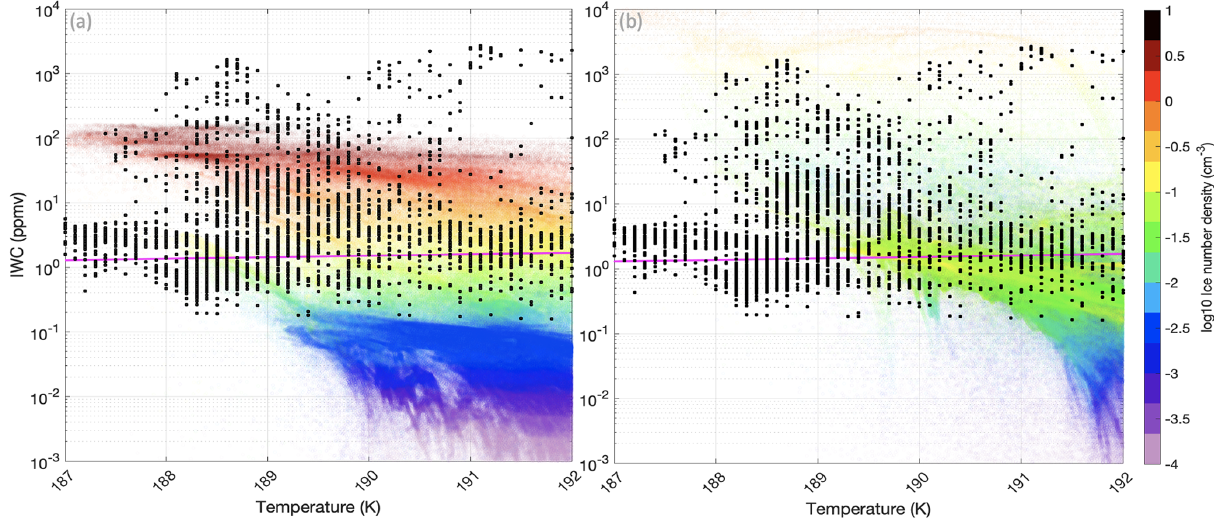
Figure 8. Simulated (shaded) and observed (black dots) IWC versus temperature color coded by the log 10 of ice number concentration at 17km and for D ice > 3µm using the (a) Thompson scheme and (b) P3 scheme.